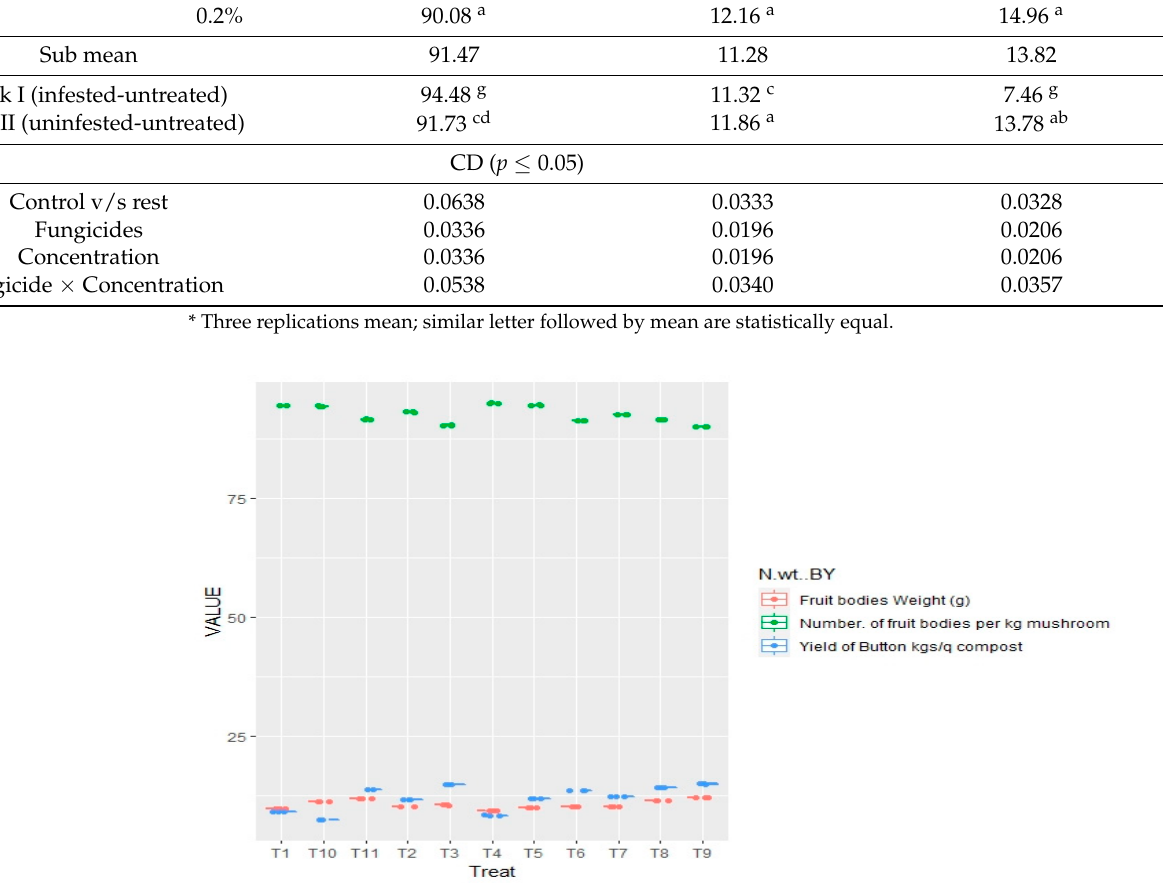
Figure 5. Boxplot designates the effect of non-systemic fungitoxicants on T. harzianum infested casing pooled during spring 2017 and 2018 on the number and weight of fruit bodies and button yield, where T1 = Prochloraz manganese 0.05% conc., T10 = Check I(infested-untreated), T11 = Check II(uninfested-untreated), T2 = Prochloraz manganese 0.1% conc., T3 = Prochloraz manganese 0.2% conc., T4 = Chlorothalonil 0.05% conc., T5 = Chlorothalonil 0.1% conc., T6 = Chlorothalonil 0.2% conc., T7 = Captan 0.05% conc., T8 = Captan 0.1% conc., T9 = Captan 0.2%